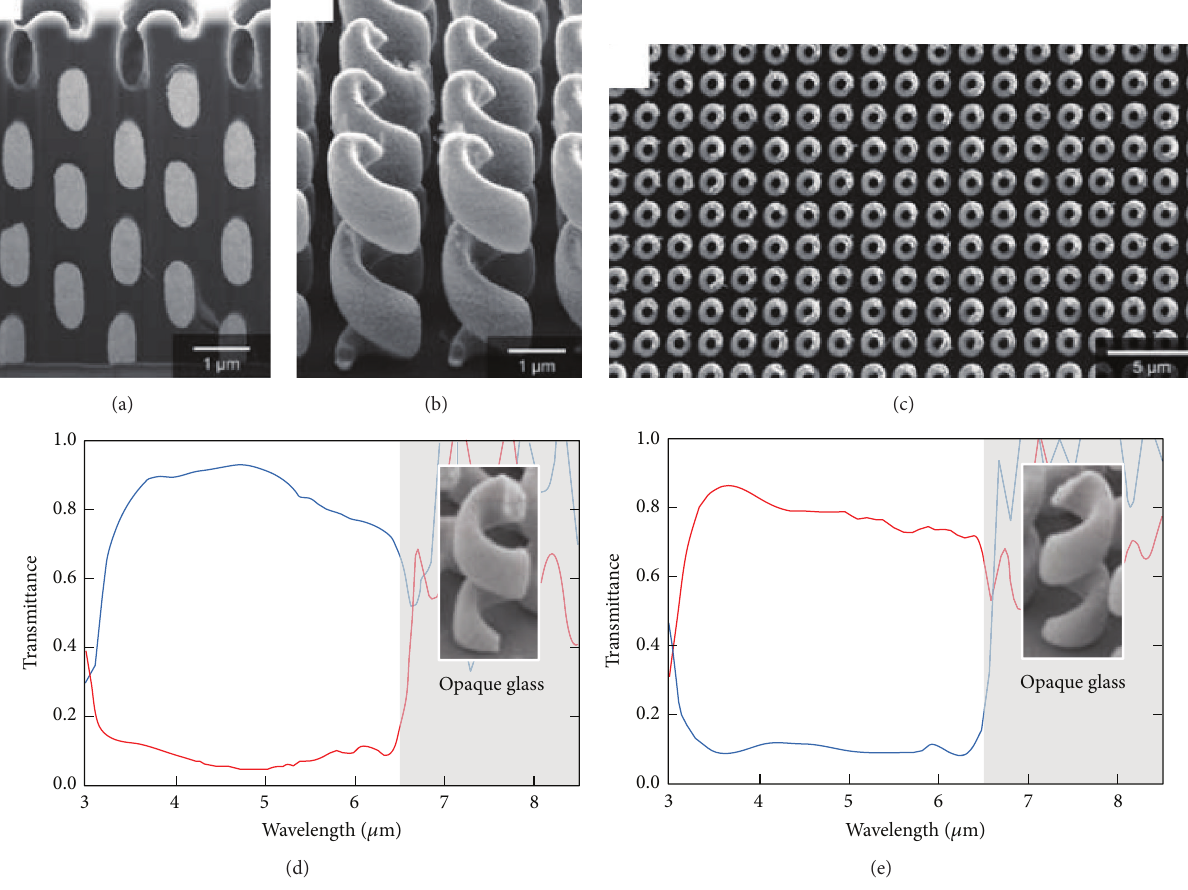
Figure 11: Geometry and the performance of the helix chiral metamaterial. (a) Focused-ion-beam (FIB) cut of a polymer structure partially filled with gold by electroplating. (b) Oblique view of a left-handed helix structure after removal of the polymer by plasma etching. (c) Top-view image revealing the circular cross section of the helices and the homogeneity on a larger scale. (d, e) Normal-incidence measured transmittance spectra for (d) two pitches of left-handed helices and (e) two pitches of right-handed helices. Figures are reproduced from